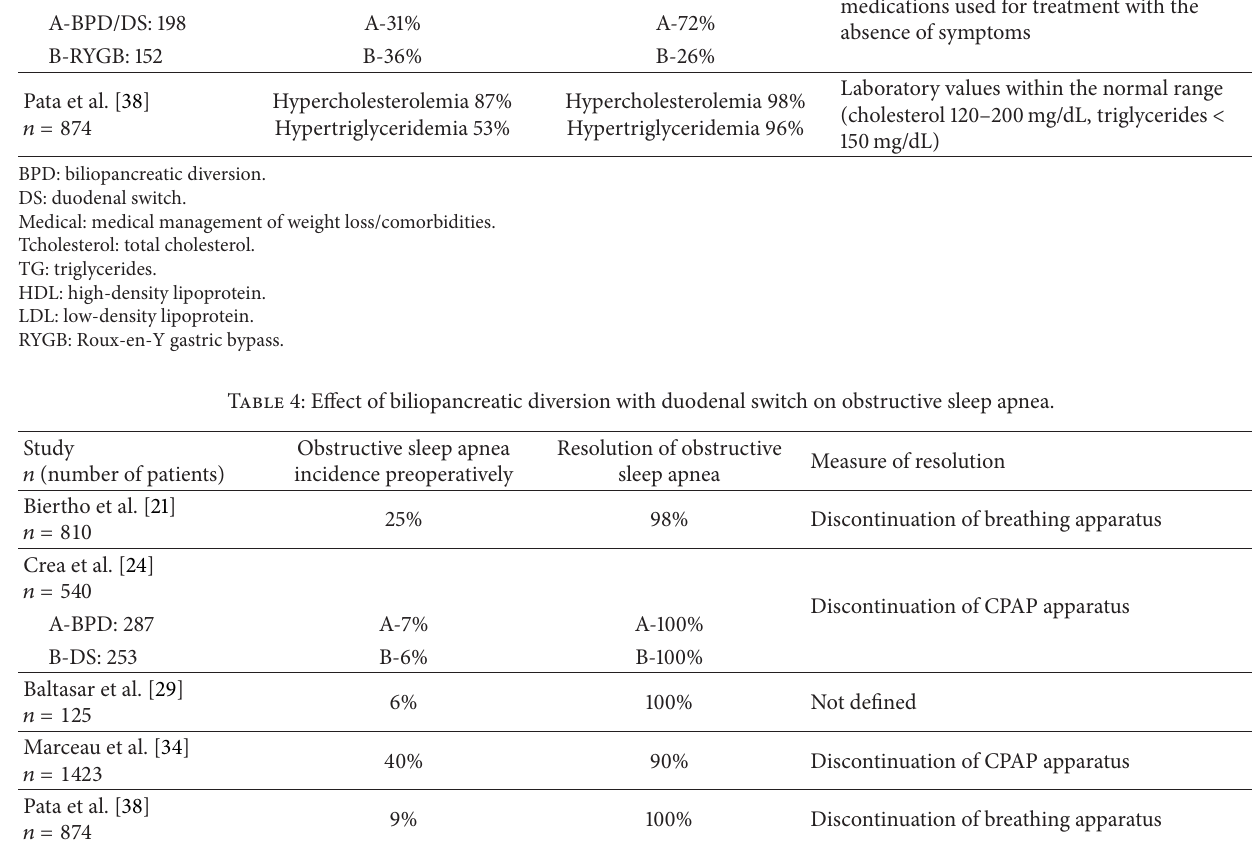
Discontinuation of breathing